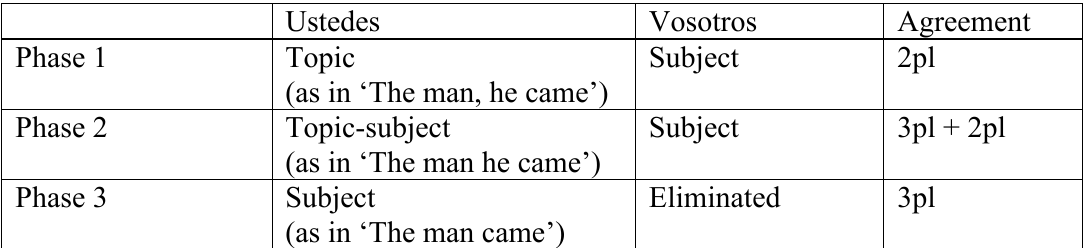
Table 3: Phases throughout the ustedes phenomenon Ustedes Vosotros Agreement Phase 1 Topic (as in ‘The man, he came’) Phase